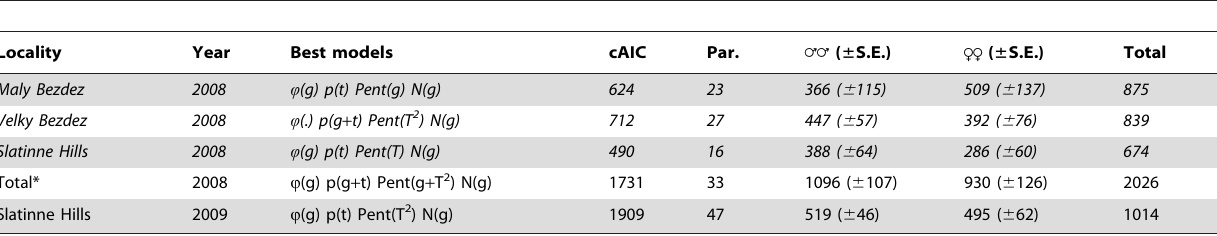
Table 2. Summary of best-supported Jolly-Seber model (POPAN parametrization) used to estimate demography parameters and population sizes of the Rosalia longicorn on the studied sites in the Ralska Upland, Czech Republic.